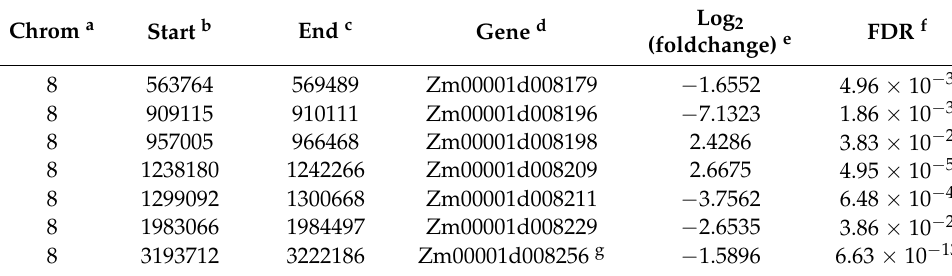
Table 2. The differential expression genes in the candidate region for the maize small-kernel mutant.